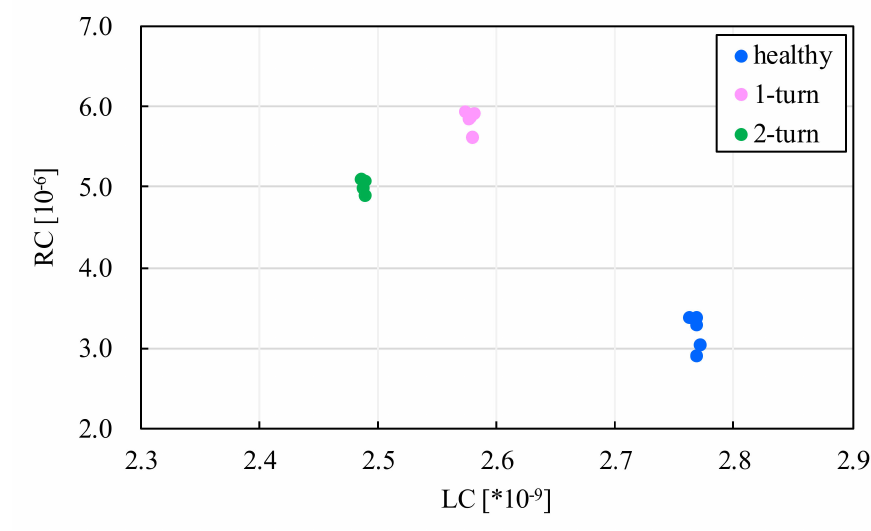
Figure 10. Feature distribution for the 1.5-kW motor